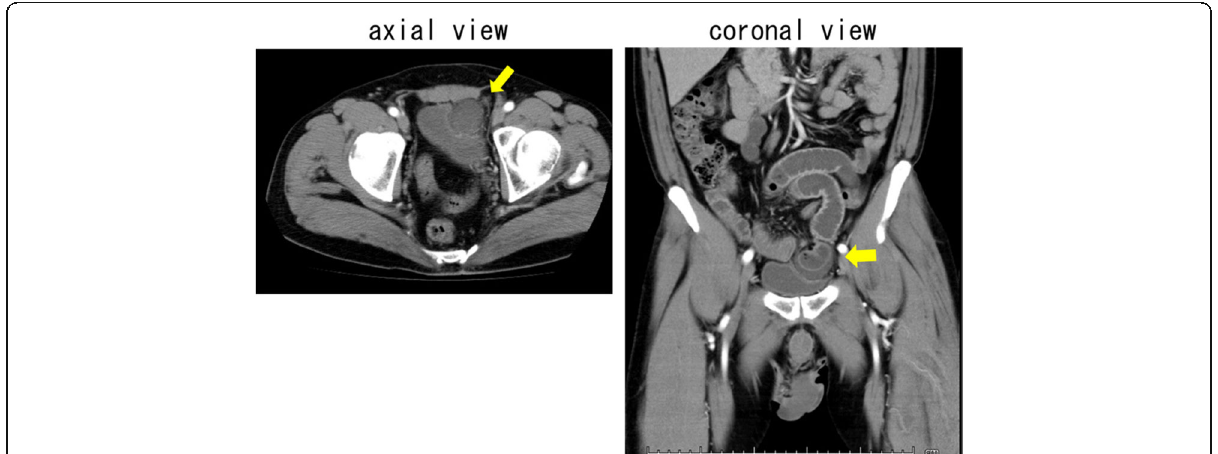
Fig. 1 Abdominal CT findings at the time of initial examination. The left side of the bladder was depressed and dilated small intestine was found in the same part, as well as ascites fluid